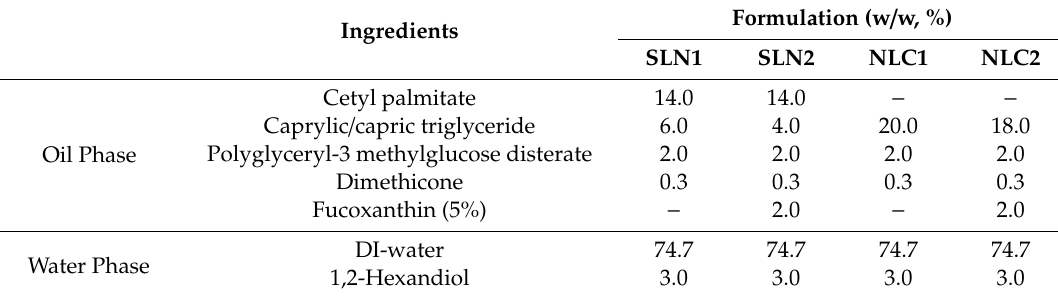
Table 1. Formulation of SLN and NLC with and without fucoxanthin (SLN1: SLN without